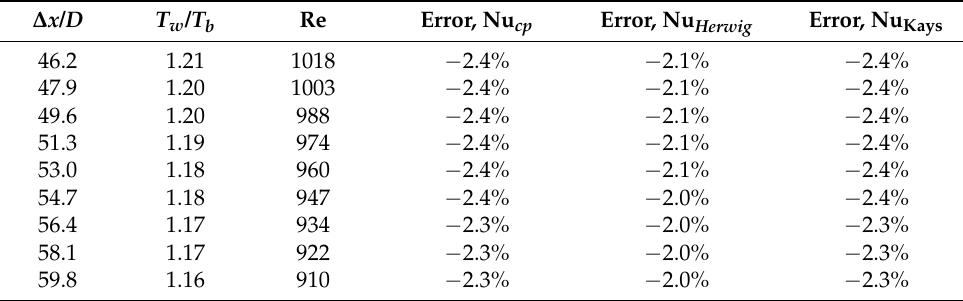
Table 9. Calculation errors of HeXe14.5 by Nu correlations with case